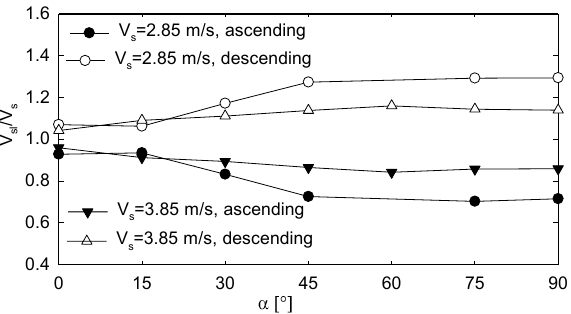
Fig. 2. Effect of pipe inclination angle α on slip ratio V sl /V s . Table 1. Effect of the pipe inclination angle α on slip ratio in ascending V sl,a /V s , and descending V sl,d /V s pipe